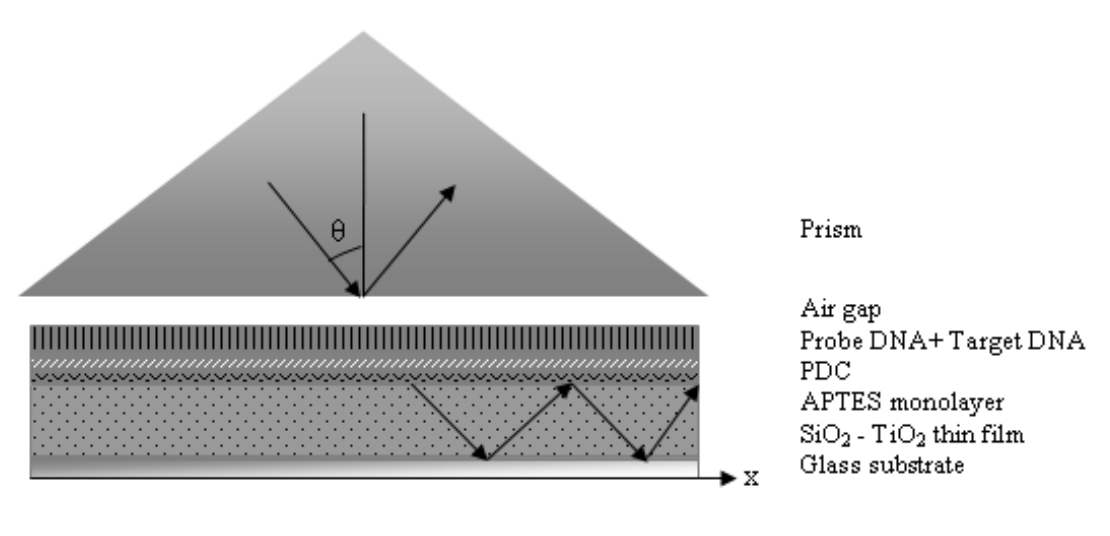
Figure 3. Schematic view of the experimental